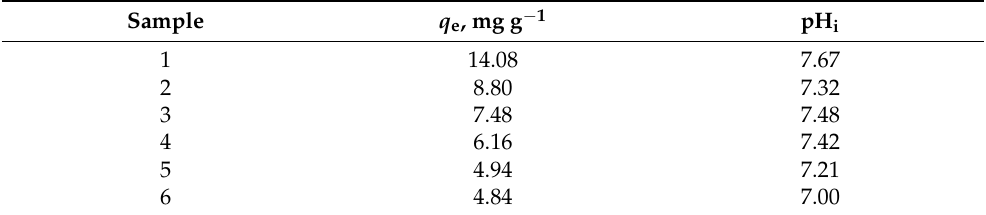
Table 3. The adsorption capacity of the A-LMS Fe 3 O 4 for Se removal from spiked drinking water.